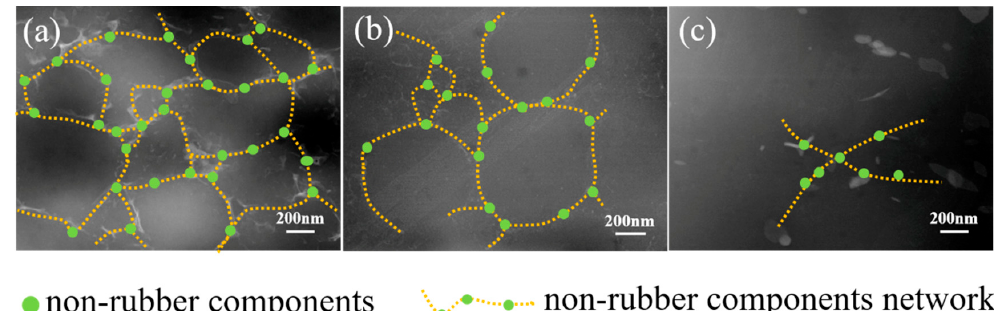
Figure 8. STEM images of NR, CNR-1, and CNR-2 after accelerated storage: NR-24 h ( a ), CNR-1-24 h ( b ), and CNR-2-24 h ( c ).